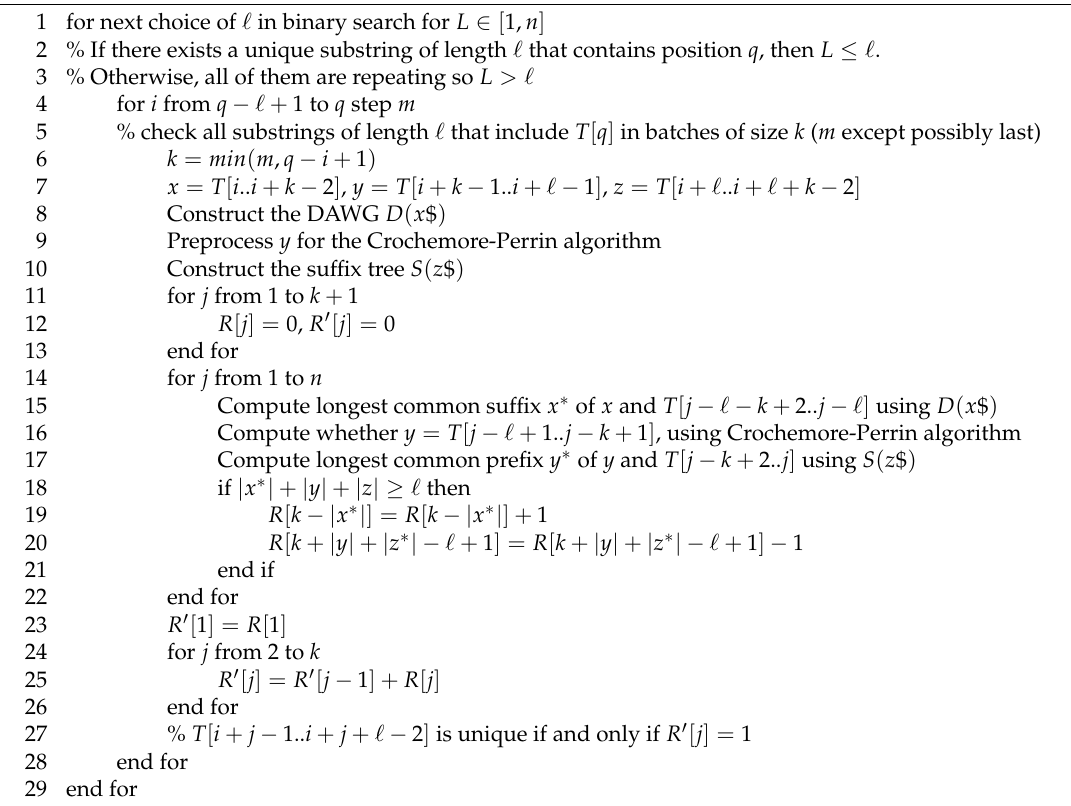
+ 1 ) n log σ log L ) ⊆ O ( n τ log σ log n ) -time algorithm to find an SUS of T [ 1.. n ] Algorithm 2 An O (( L m containing T [ q ] , where L is the length of the